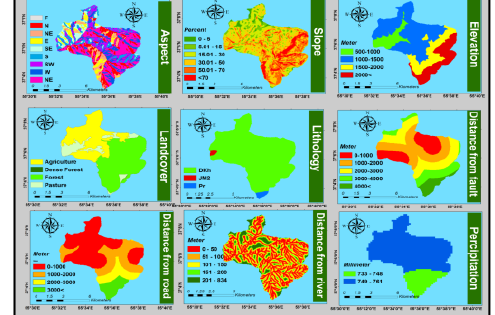
Figure 3. Input data